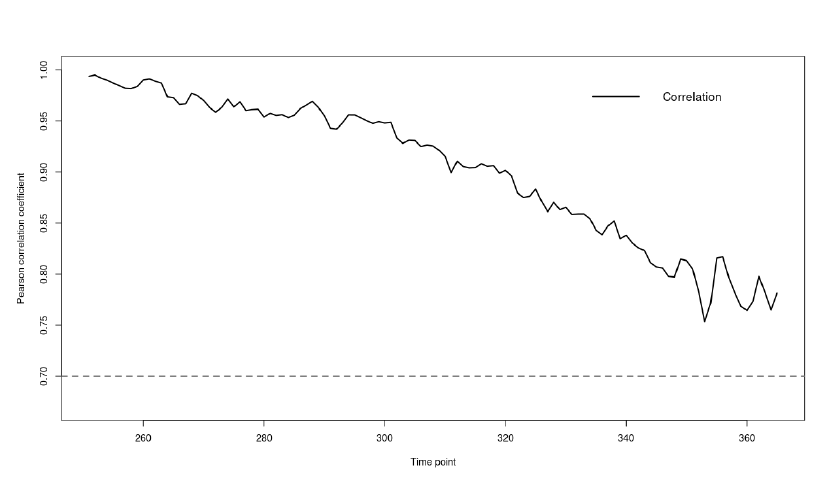
Figure 9. Time correlations of temperature in the Canadian weather example.